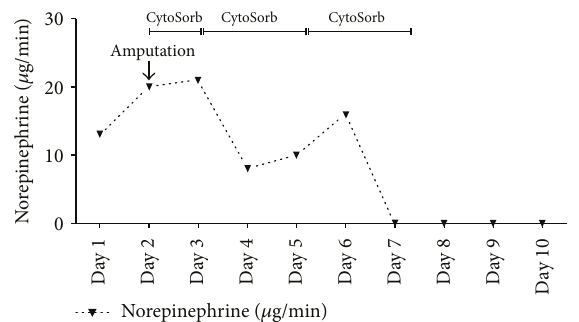
Figure 6: Shown is the need of vasopressors (Norepinephrine) during the course of the three Cytosorb sessions. Day 1 represents start of treatment after postoperative transfer to the